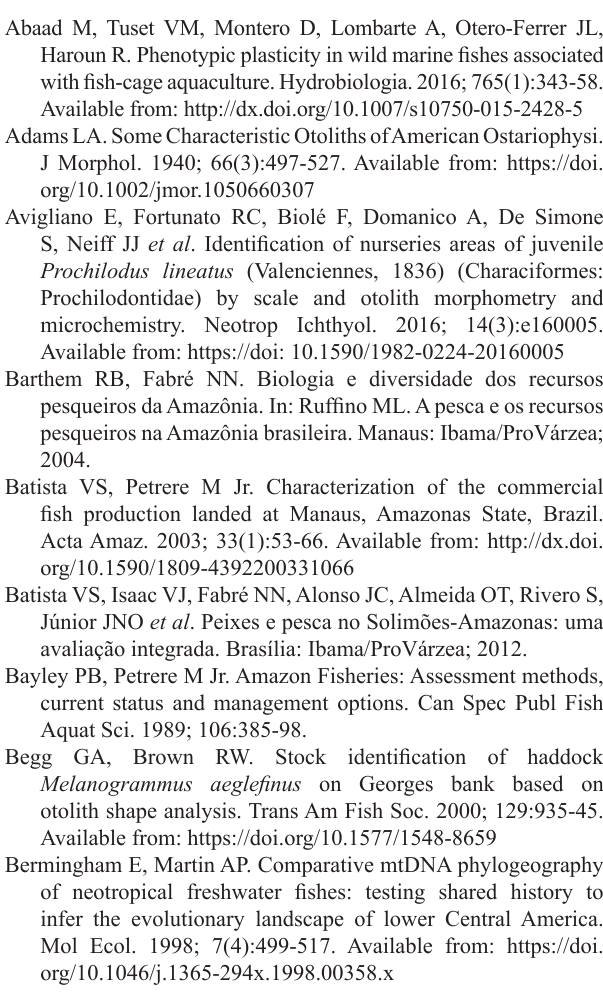
Fig. 5. Canonical variate analysis of the organized data of the analysis cluster. Representation the four different mor- photypes of asteriscus otoliths of Prochilodus nigricans . (red cross) Morphotype 3; (blue square) Morphotype 2; (purple asterisk) Morphotype 4; (green ex) Morphotype